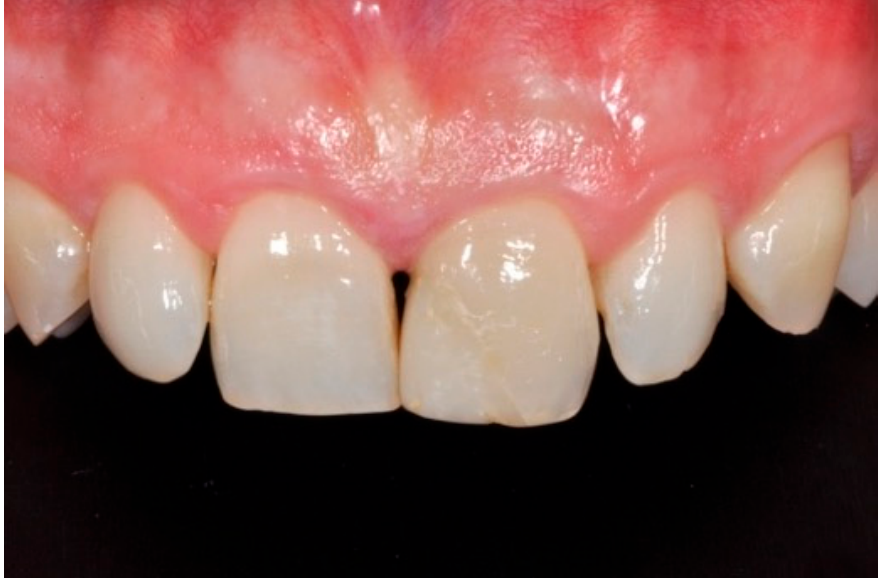
Figure 41. Initial clinical situation.